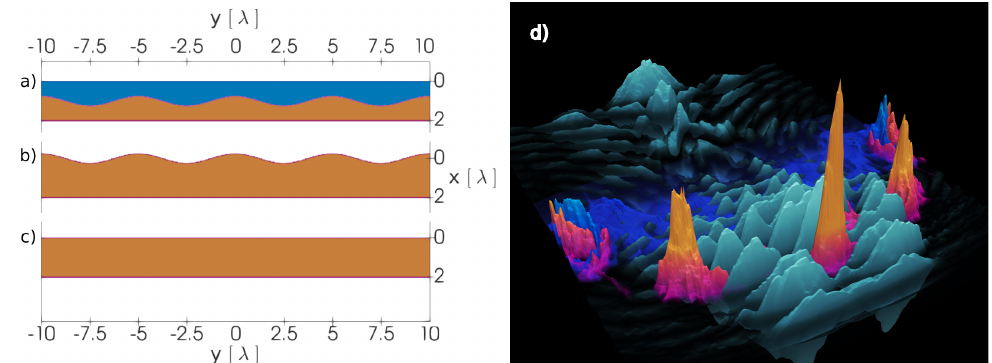
Figure 5. Structured targets and generation of proton bunch, source of the left part ( a – c ) [76]. Initial configuration of deuterium layer (blue) and proton layer (orange) in the cases: ( a ) double–layer target with the modulation on the interface, ( b ) single–layer target with the modulation on the front surface, ( c ) without the modulation. ( d ) Visualization of case ( a ) during the laser–target interaction. Coloring: electric field (gray), density of deuterium (blue) and hydrogen (orange). Colors saturated with maximum value set to the initial density. Values are also represented by the vertical height. The